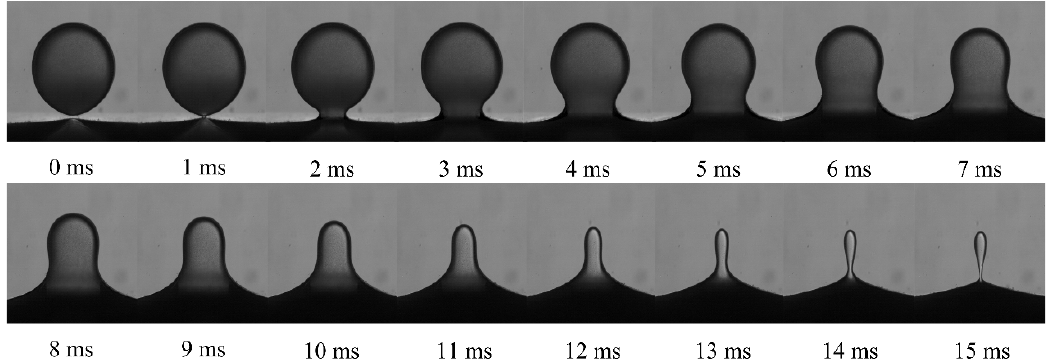
Figure 6. Morphological evolution during droplet–interface electro-coalescence with a particle concentration of 1 wt%.